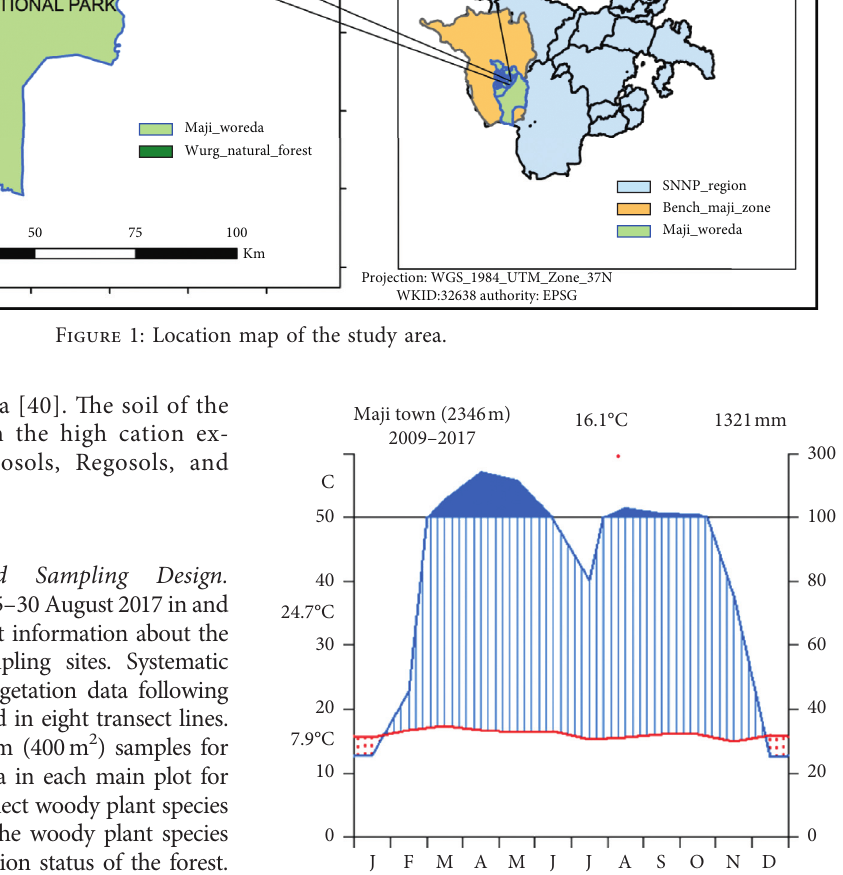
Figure 2: Climadiagram of Maji (the closest